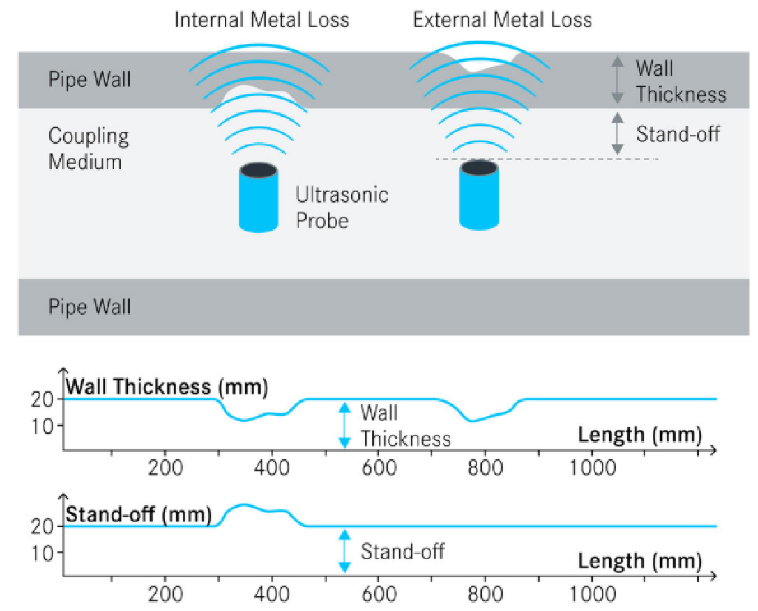
Figure 4. Ultrasonic texting that can discriminate between internal and external mass loss.